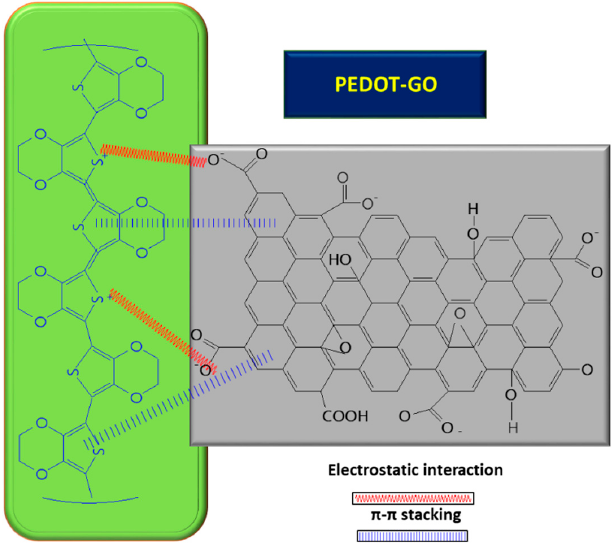
Figure 4. Interaction between GO and PEDOT, inside the composite used for UA detection.